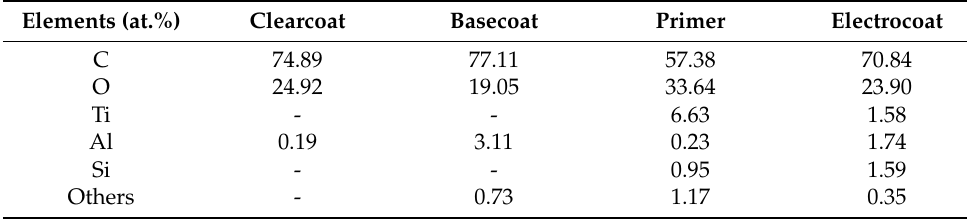
Table 5. Chemical compositions of each paint film determined by SEM. Elements (at.%) Clearcoat Basecoat